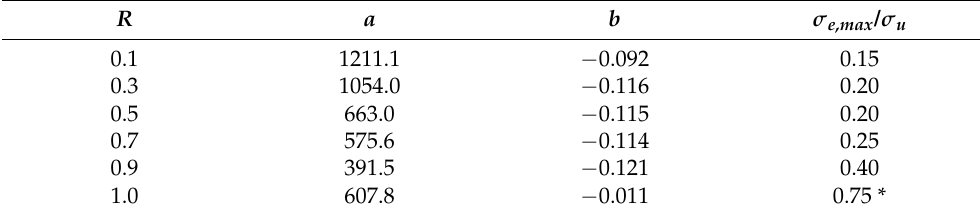
Figure 5. ( a ) Creep rupture strength diagram and creep strain until failure, and ( b ) comparison of fracture surfaces for short and long creep lives ( scale bars are 50 μm). Table 2. Fatigue life parameters of BFPP rods.